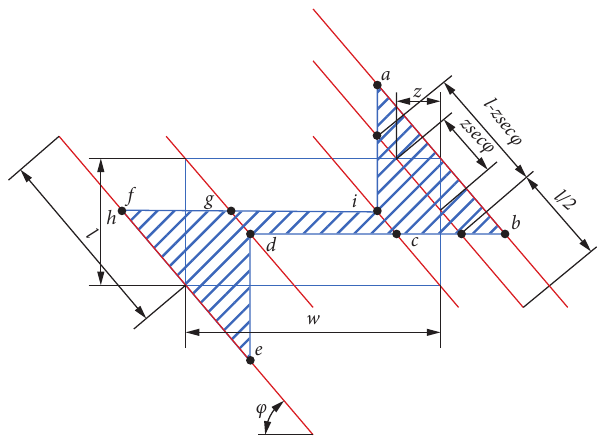
Figure 2: Discontinuities with both ends censored, l ≥ ( h /sin φ ) and φ ≥ tan − 1 ( h / w ) .